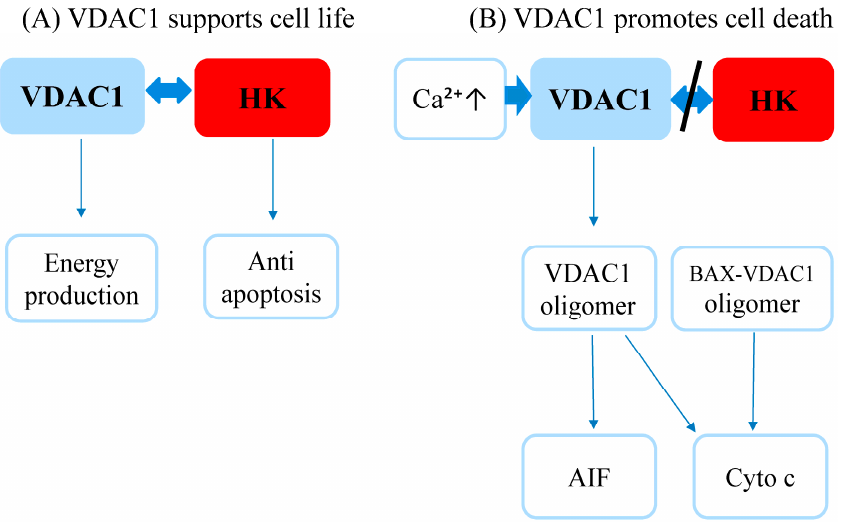
Figure 4. VDAC1 live or die flow chart: a schematic representation of VDAC1 involvement in cell survival ( A ) or death ( B ). ( A ) VDAC1 attaches HK, inducing cell energy production and protection from mitochondria-mediated apoptosis by blocking the interactions with pro-apoptotic BAX proteins. ( B ) Elevated Ca 2+ levels and detachment of HK from VDAC1 promotes the oligomerization of VDAC1 to create large pores capable of passing apoptogenic proteins AIF and Cyto c. In addition, VDAC1 forms an oligomer complex with BAX proteins to create a pathway for Cyto c. Abbrevia-